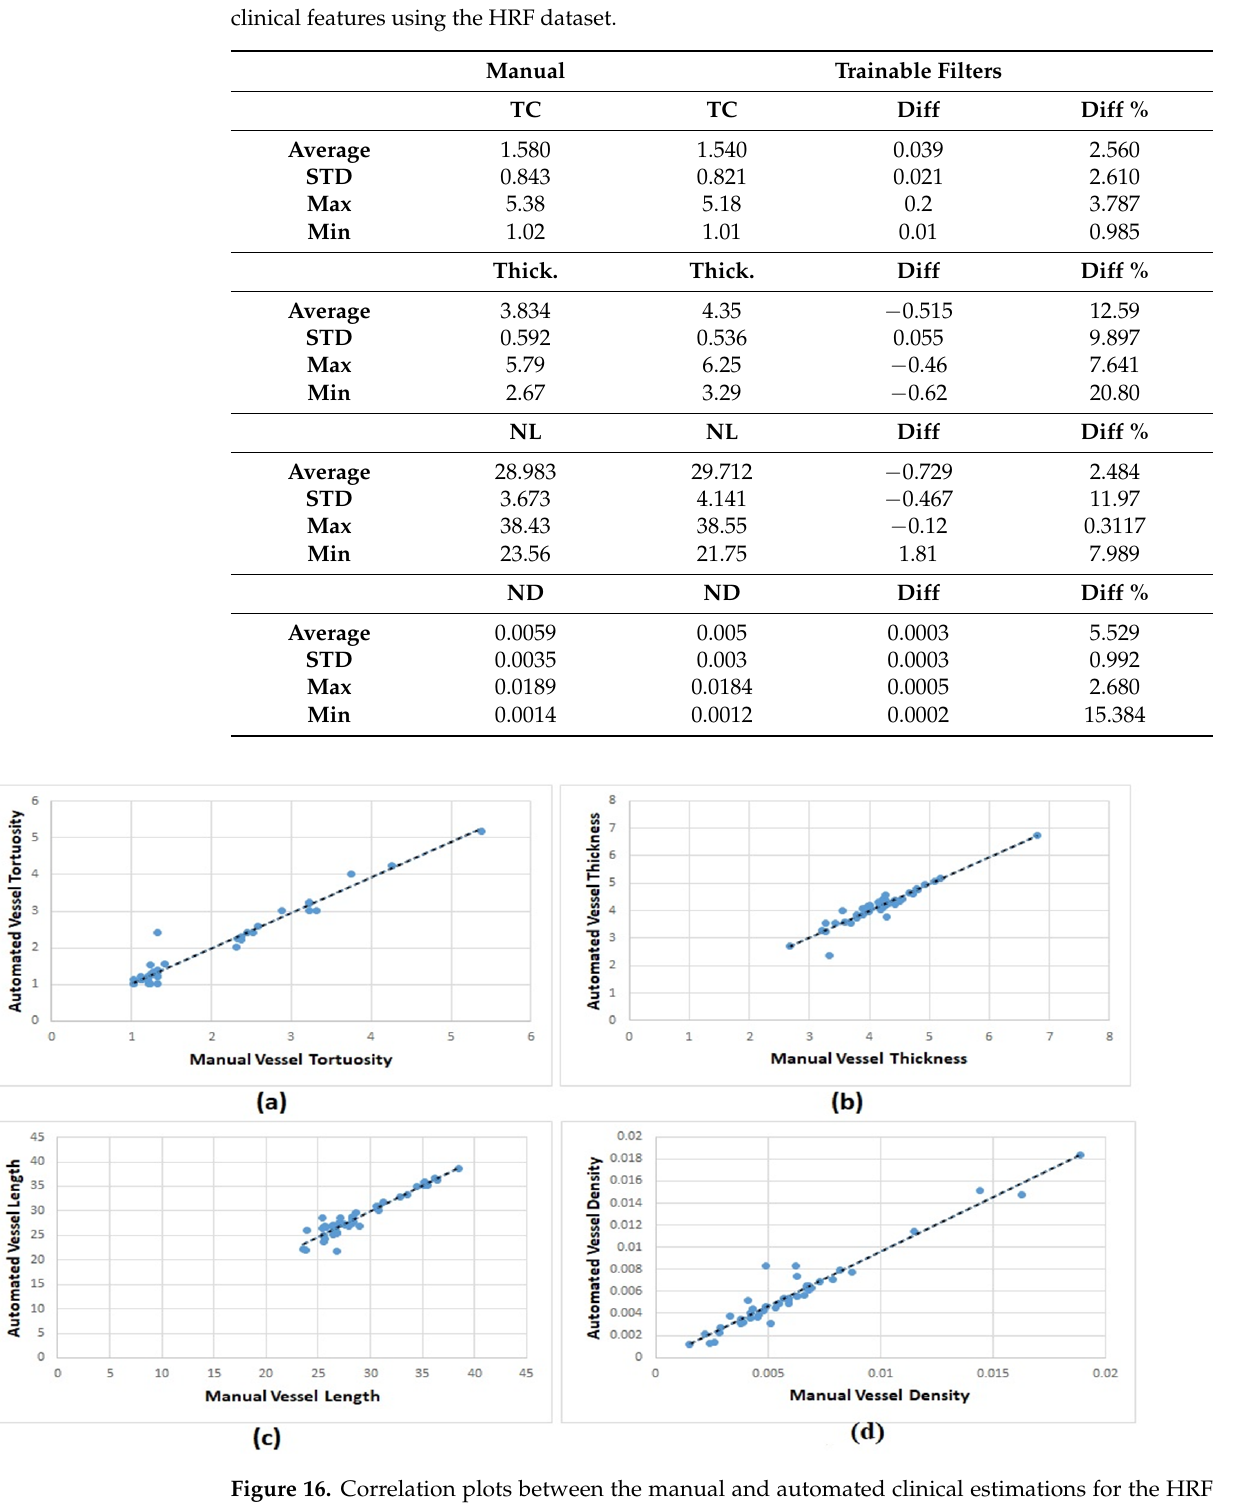
Table 7. Performance comparison conducted between the manual and automated estimations of four clinical features using the HRF dataset.